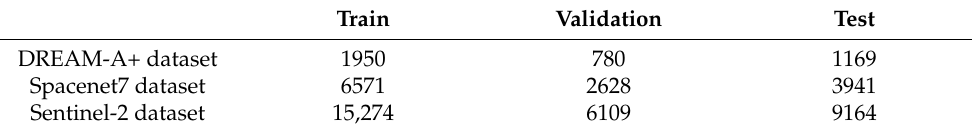
Table 1. Number of image tiles in the train set, validation set, and test set for each dataset.